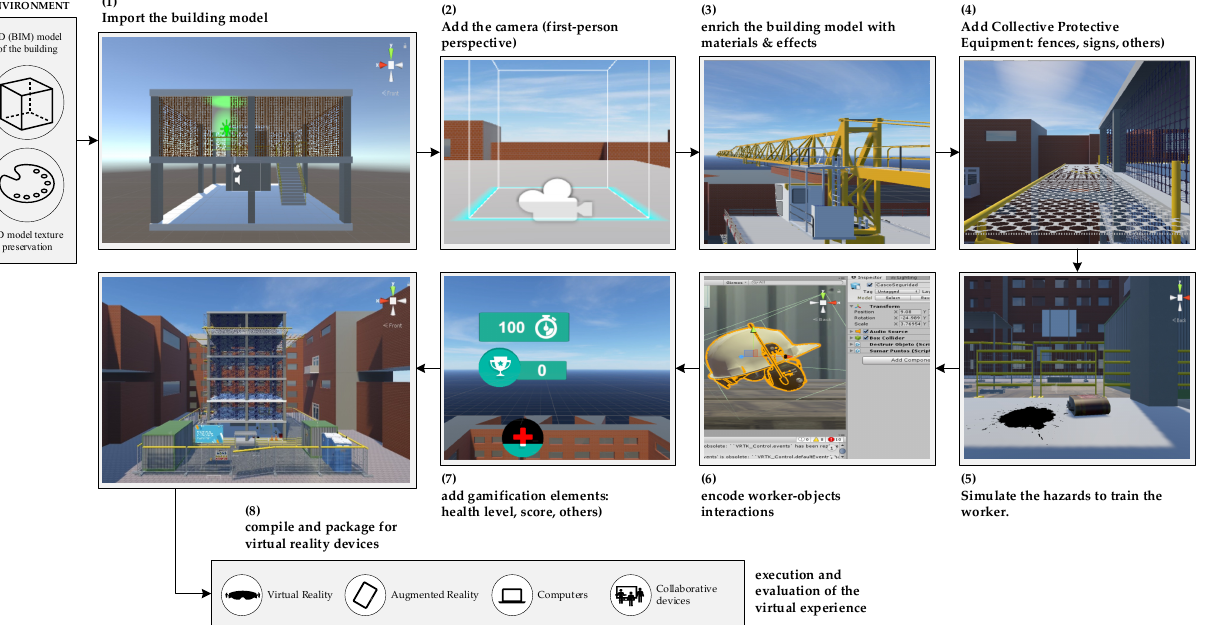
Figure 10. Basic workflow for creating virtual reality OHS experiences.